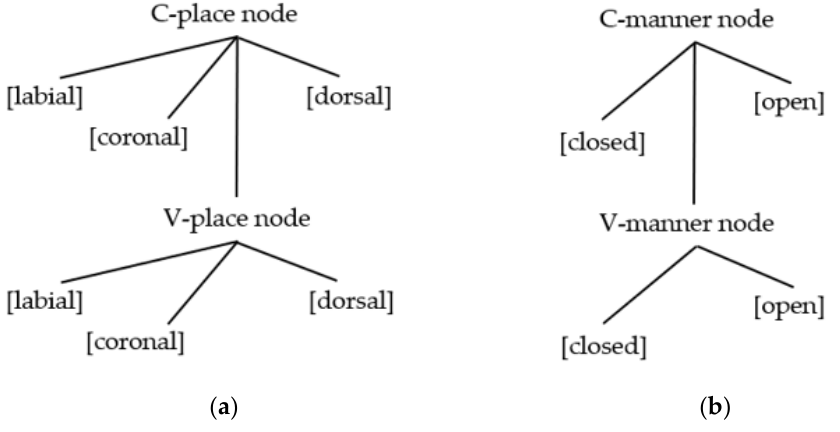
Figure 1. Basic PSM geometry. ( a ) Place tier; ( b ) Manner tier.